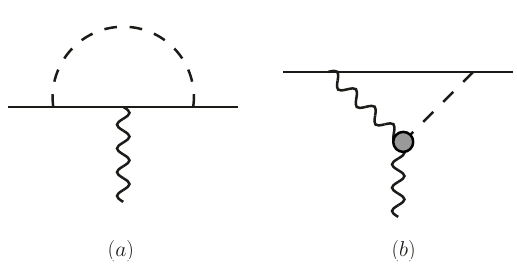
Figure 1 . 1- and 2-loop contributions to ( g − 2) e from a pseudo-scalar with couplings to the first generation fermions. The effective vertex is generated at low energies through the meson mixing angles, eq.